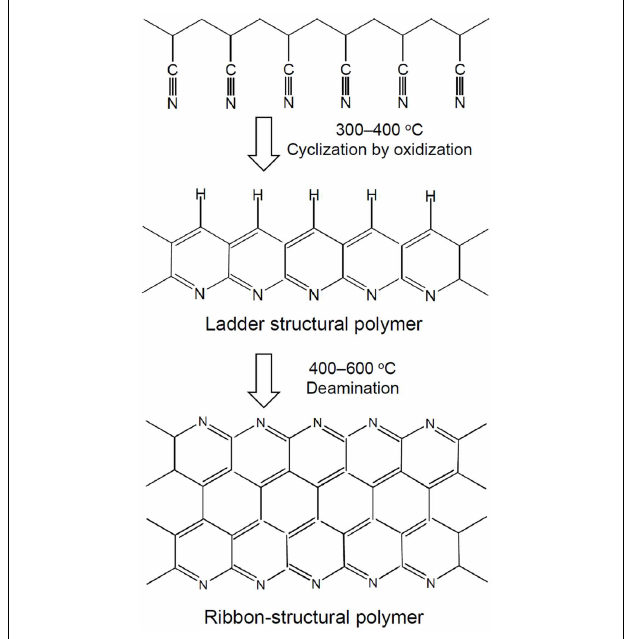
FIGURE 4 | Schematic chemical structure of SPAN . Modified from Fanous et al.